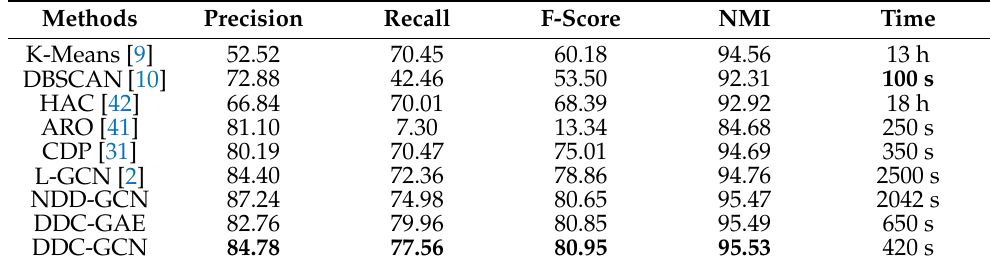
Table 5. Comparison on MS-Celeb-1M datasets.